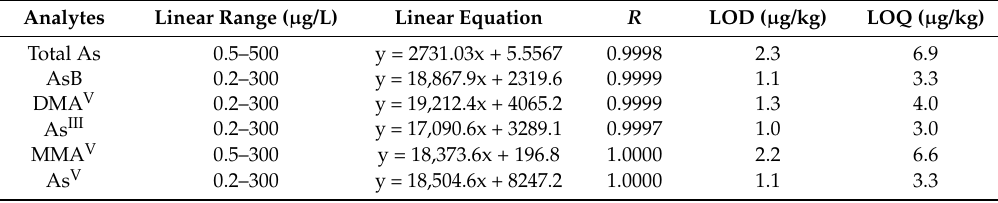
Table 1. Analytical performance of inductively coupled plasma mass spectrometry (ICP-MS) for total arsenic content and HPLC-ICP-MS for arsenic